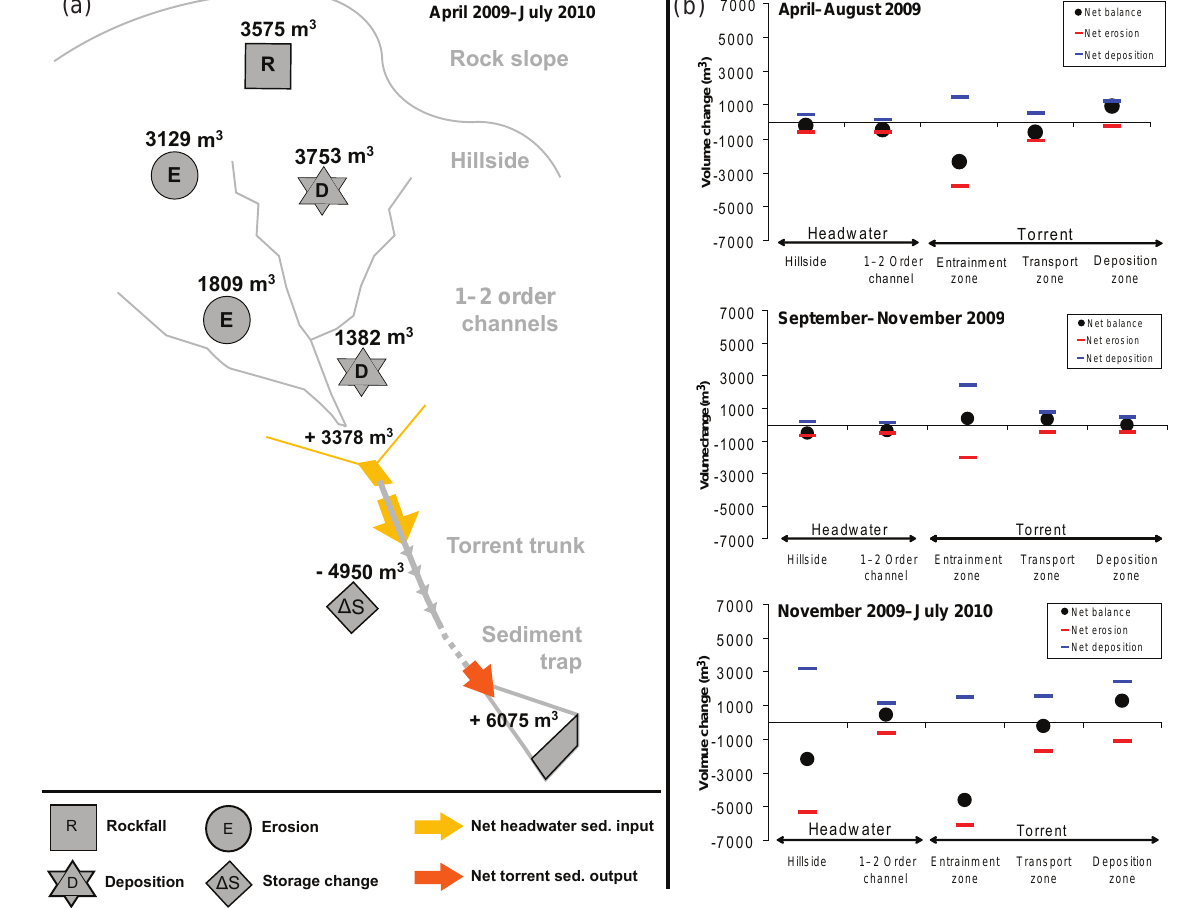
Figure 12. Overall sediment budget (a) and net sediment balance (b) for each monitoring period showing the overall transfer dynamics from debris source zone in the headwater to the apex of the fan through the torrent observed during the period of